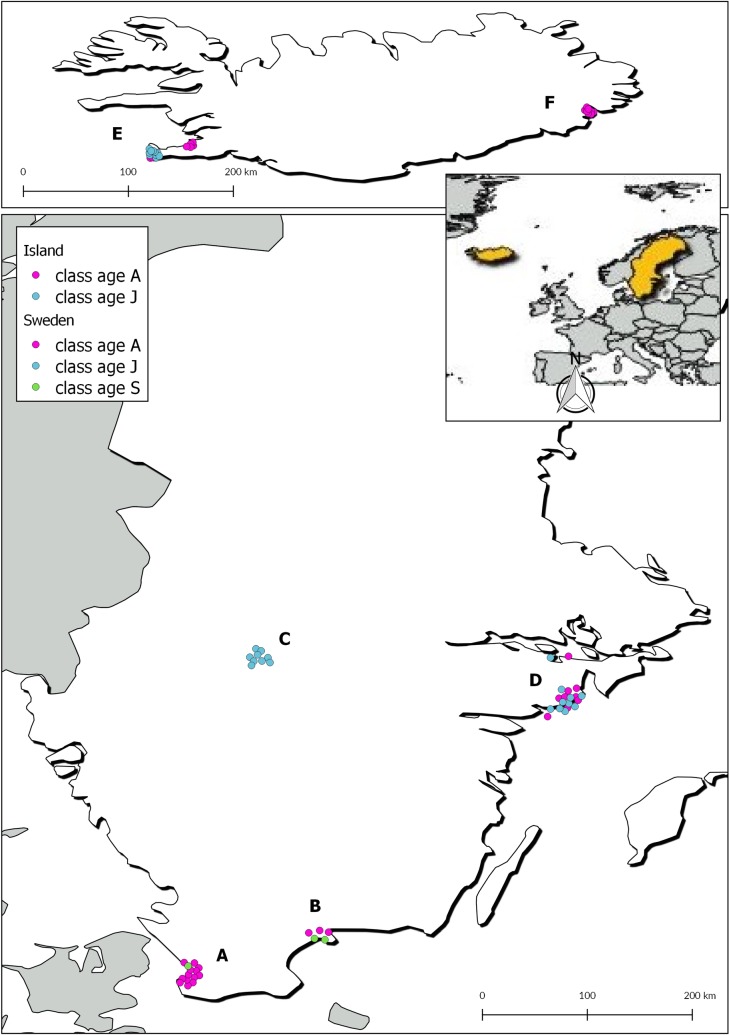
Maps of Sweden and Iceland showing collection sites of Herring gulls (Larus argentatus) included in the study.Adult birds are shown in pink, subadults in green and juveniles in blue. A = Malmö, Skåne, B = Blekinge Archipelago, C = Lake Vänern, D = Södermanland, E = South-western Iceland, F = Eastern Iceland. (Software QGIS, map ESRI Europe, projection EPSG:4326, WGS84). Reprinted from Data and Maps, 1998 under a CC BY license, with permission from ESRI Sverige, original copyright 1996, 1998.